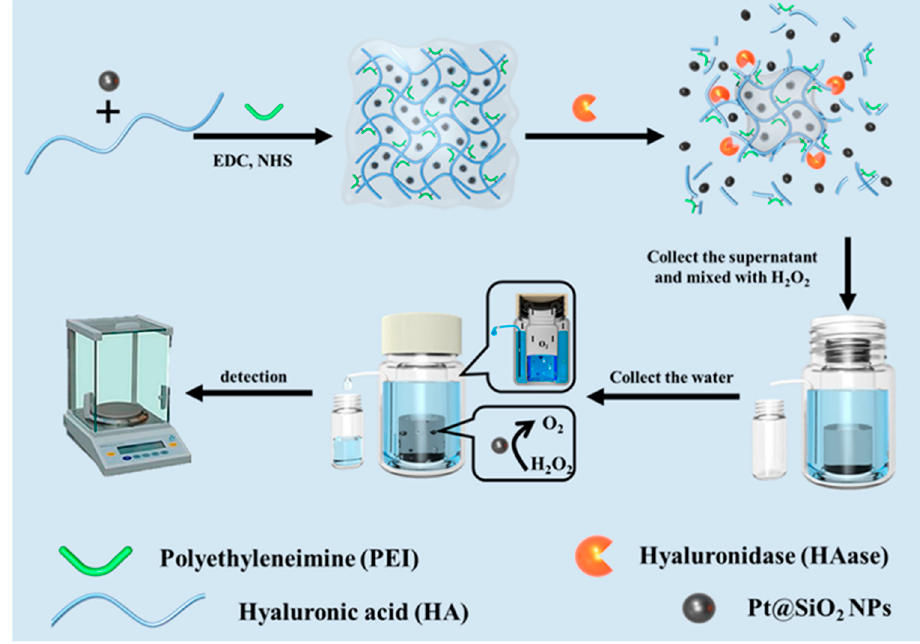
Figure 8. Schematic illustration of HA hydrogels containing Pt@SiO 2 NPs for HAase detection using electronic balance as readout device. Reproduced with permission from Zhixin Li, Analytical Chemistry; published by American Chemical Society, 2019.